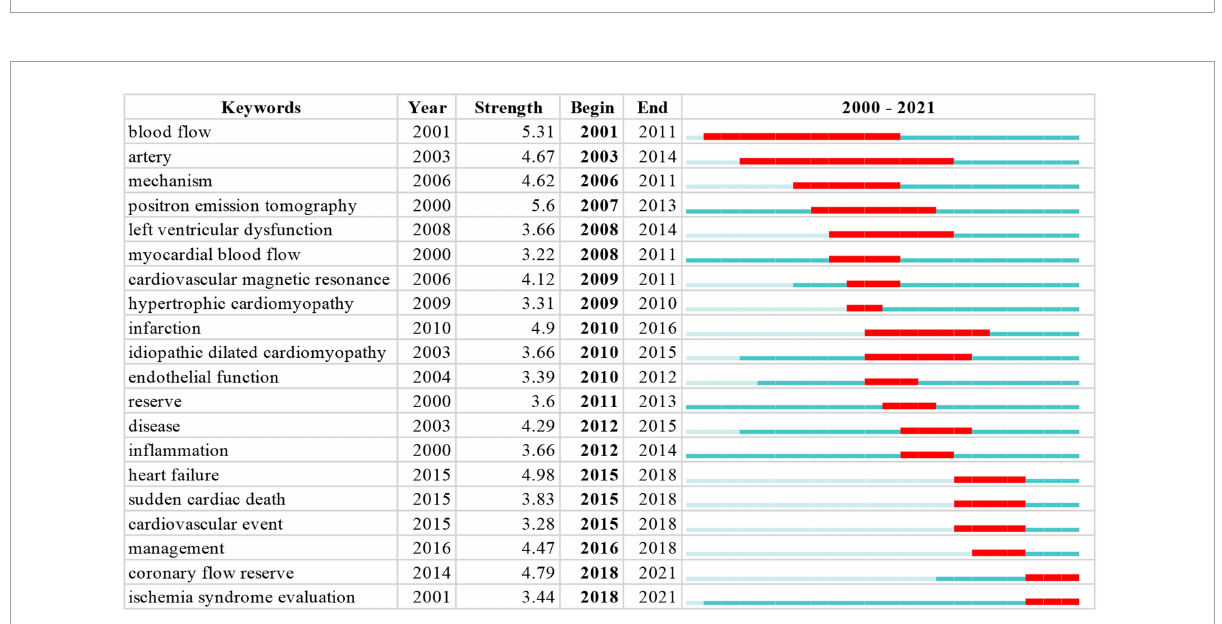
FIGURE5 Visualization of keyword co-occurrence analysis. The size of nodes indicates the frequency of occurrences of the keywords. The lines between the nodes represent their co-occurrence in the same publication. The shorter the distance between two nodes, the larger the number of co-occurrence of the two keywords.